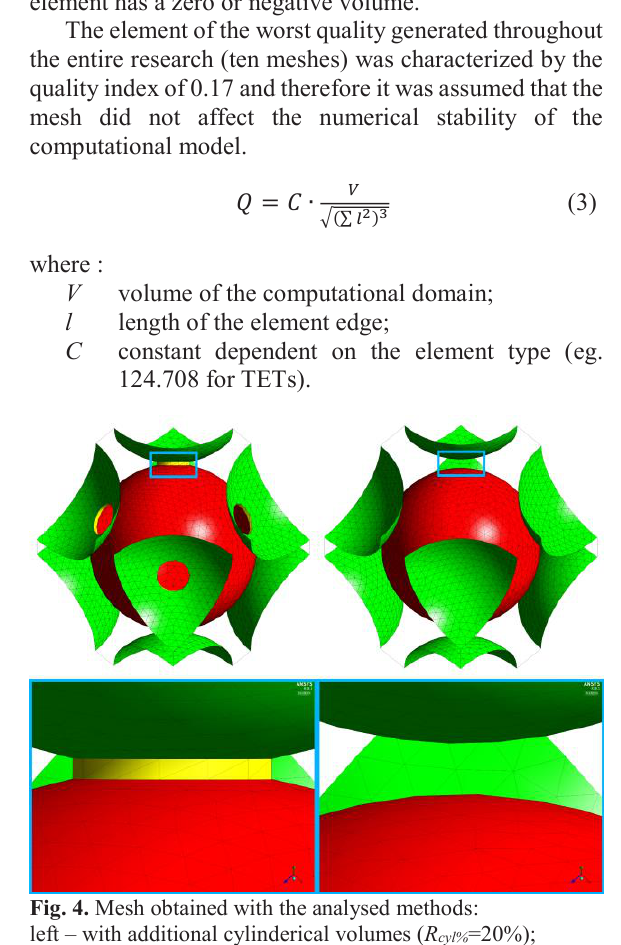
Fig. 6. Average relative velocity magnitude along outlet line